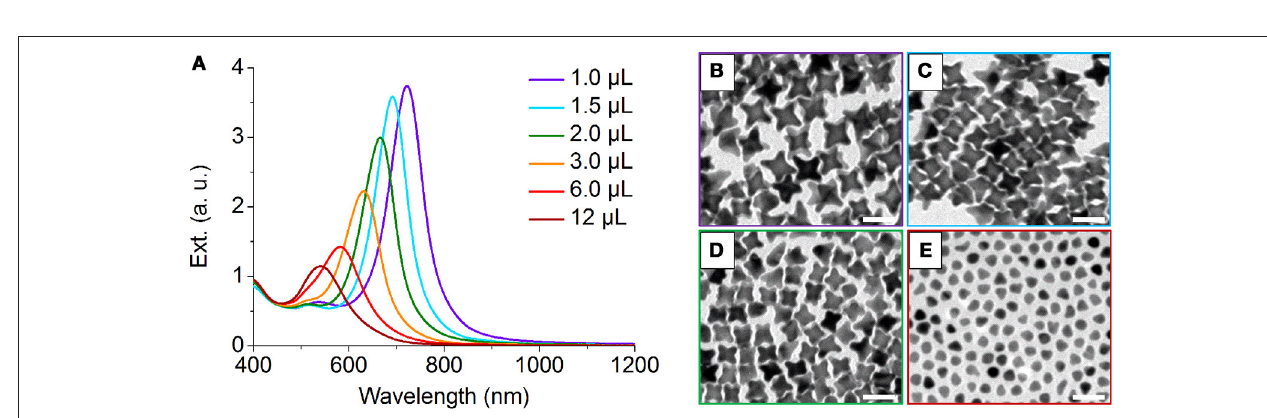
FIGURE 4 | (A) UV-Vis-NIR spectra of NOPs by increasing the volume of Au seeds solution from 1.0 to 12 µ L added to the growth solution (total volume of 10mL). (B–E) TEM images of NOPs with 1.0, 1.5, 2.0, and 12 µ L Au seeds solution added to the growth solution, respectively. Scale bars: 50nm.